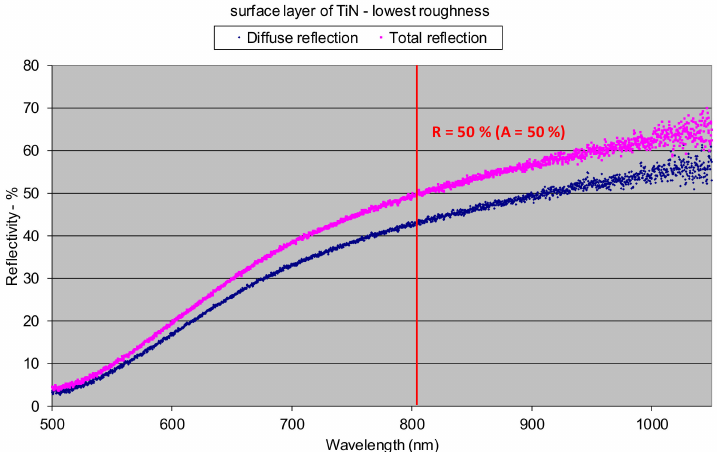
Figure 9. Reflectivity of the surface layer produced by nitriding of titanium Ti6Al4V by HPDDL in pure nitrogen, determined at room temperature (bead No. 5 in Figure 9, parameters of processing; laser power 1.8 kW, scanning speed 400 mm / min, energy input 270 J / mm, surface roughness Ra 8.2, thickness of the titanium nitrides surface layer approx. 2–5 µ